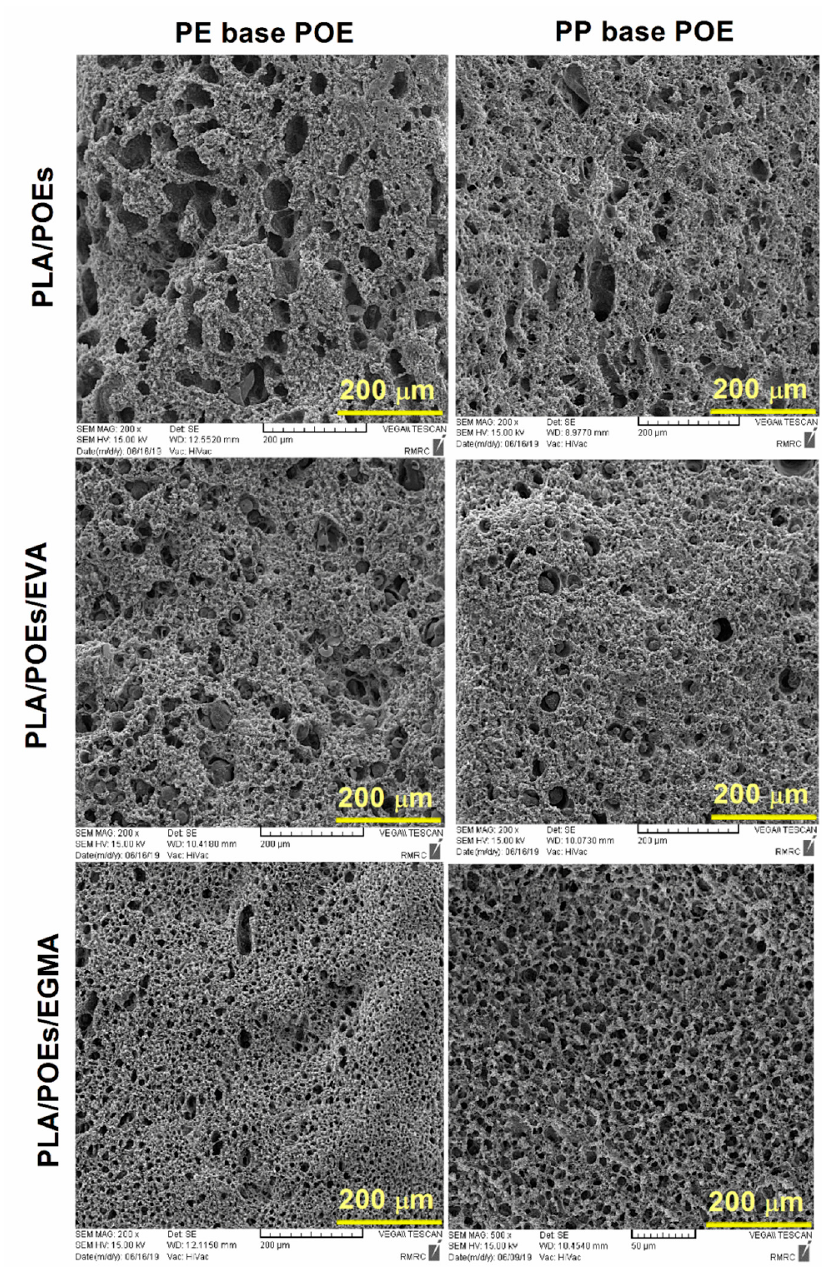
Figure 2. SEM photomicrographs of the prepared PLA/POE samples containing different compatibilizers.